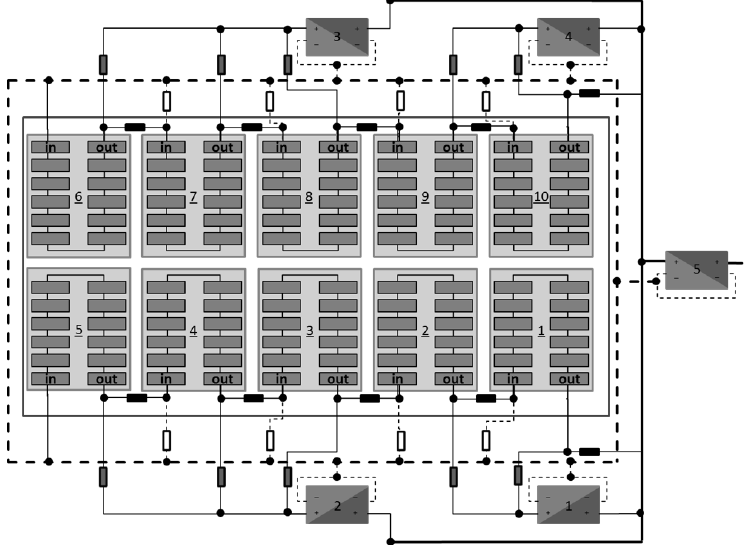
Figure 1. Schematic representation of the smart reconfigurable photovoltaics (PV) panel proposed by Baka et al. [16]. There are 10 substrings of 12 ‘half-cells’ each. On the outside, components 1–4 represent the local DC–DC converters. Component 5 represents the module level converter. The reconfiguration switches allow the different